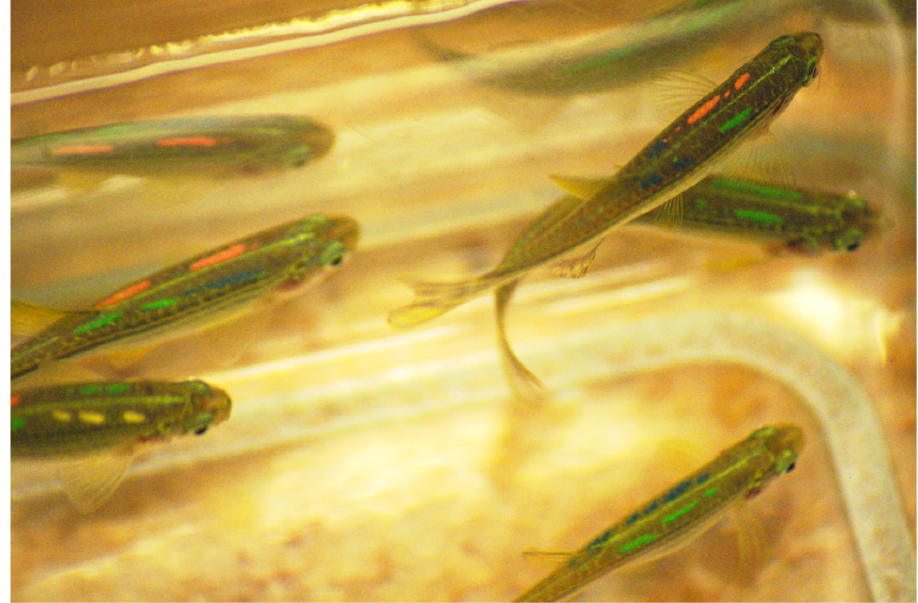
Figure 2. A group of zebrafish tagged with elastomer (VIE) injected beneath the skin. Visible are four coloured marks. Photo credit: Anita Rácz.